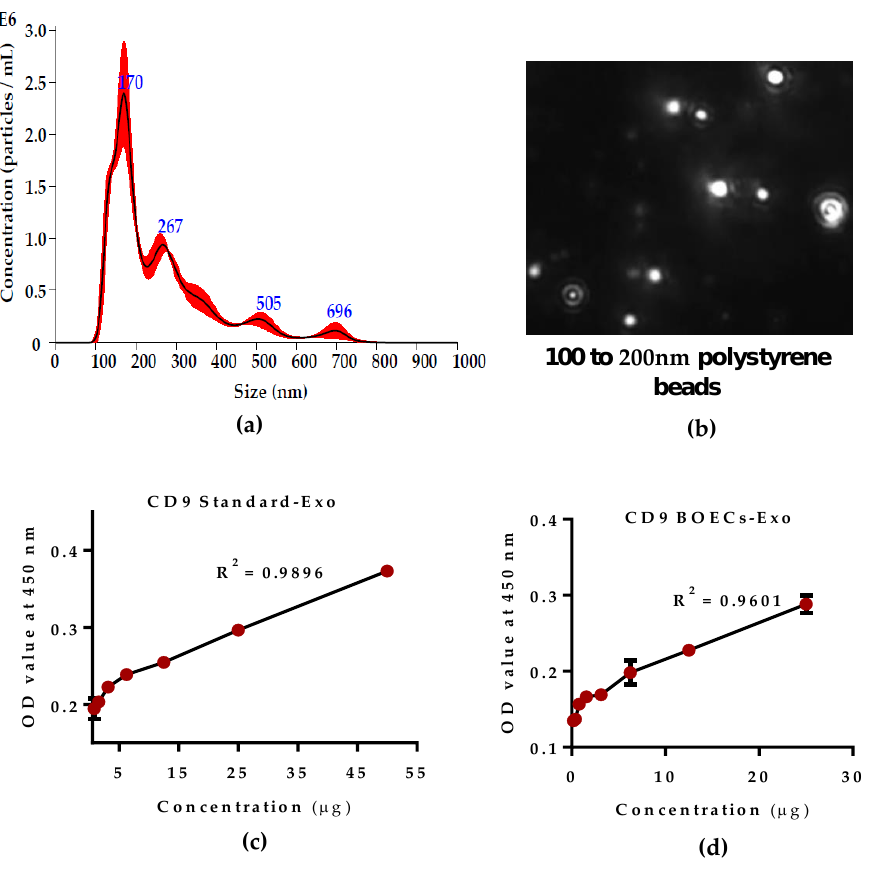
Figure 2. Characterization and quantification of BOECs-derived exosomes (Exo). ( a ) Size distribution of BOECs-derived Exo measured by nanoparticle tracking analysis (NTA) using 100 × sample dilution. Graphical representation of data showing the quadratic interpolation of mean number of particles present in 100 × dilution sample. ( b ) Screen shot of NTA of 100–200 nm beads. ( c , d ) ELISA graph presenting the quantification of BOECs-derived Exo protein concentration. OD values of Exo-specific CD9 antibody represents the concentration of protein. The Standard-Exo used to generate the calibration curve for quantitation of Exo carrying CD9 from Exo-ELISA data. Data are presented as a result of ± SEM (standard error of mean) of three